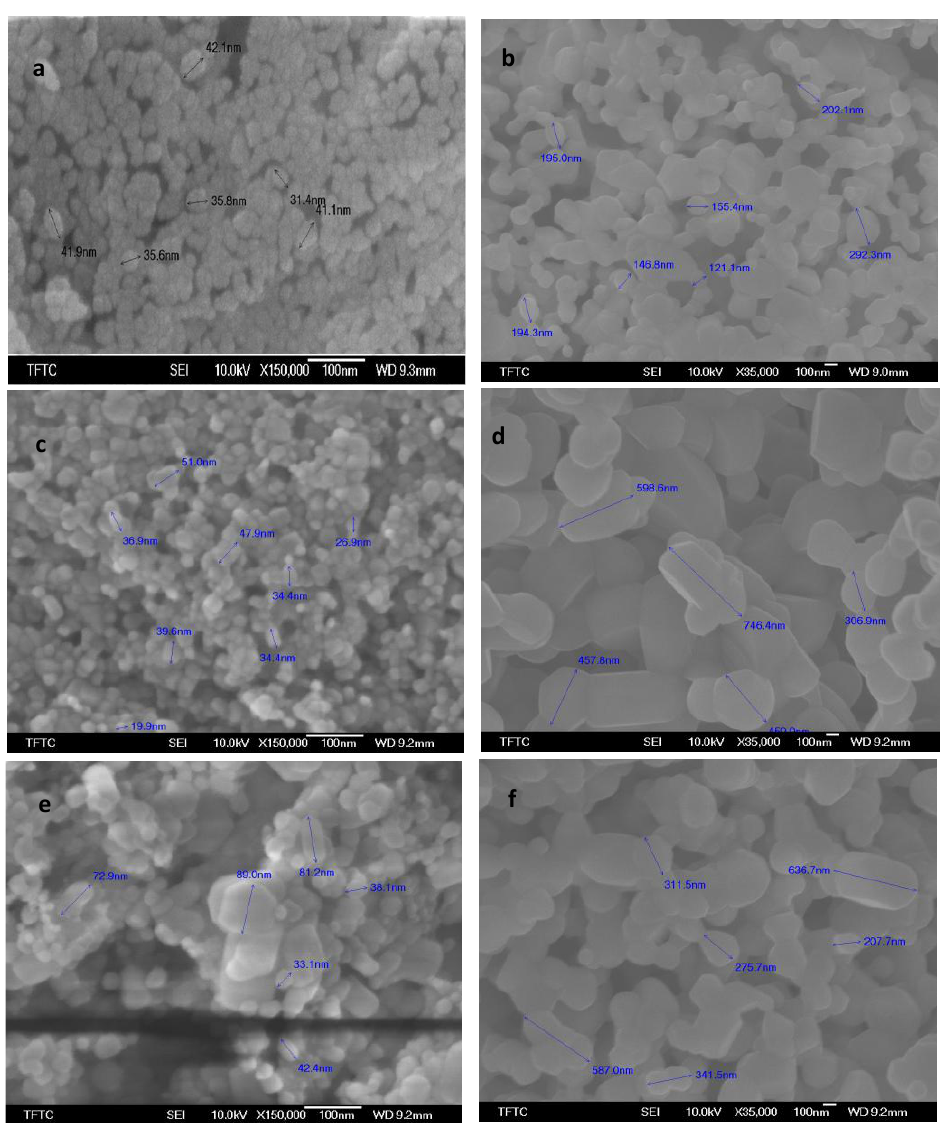
( c ) 5. SEM of ( a ) ZnO-CTS-450; ( b ) ZnO-CTS-850; ( c ) ZnO-CMC1-450; ( d ) ZnO-CMC1-850; ( e ) ZnO-CMC4-450; and ( f )